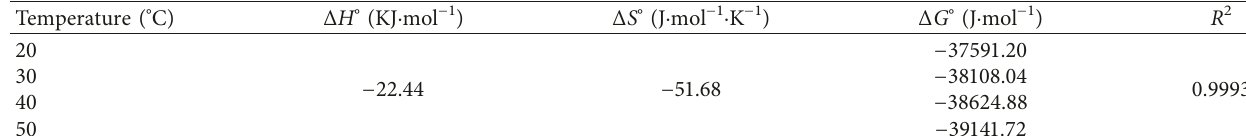
Figure 8: ln K d versus 1/ T for the adsorption of DM on PB. Table 1: Thermodynamic parameters of the adsorption process of DM on PB.